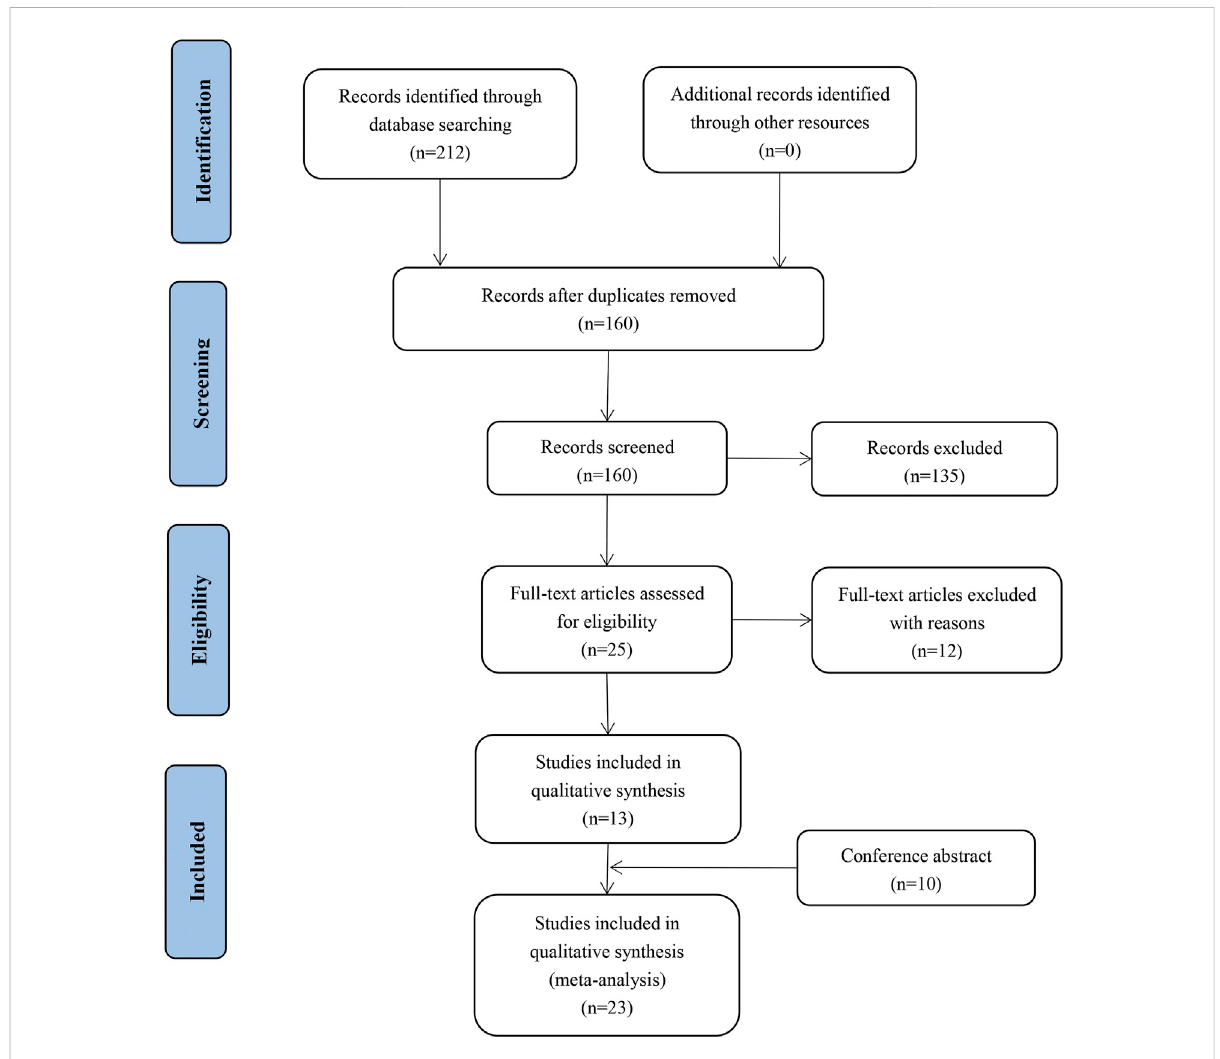
FIGURE 1 Literature search and selection process fl ow